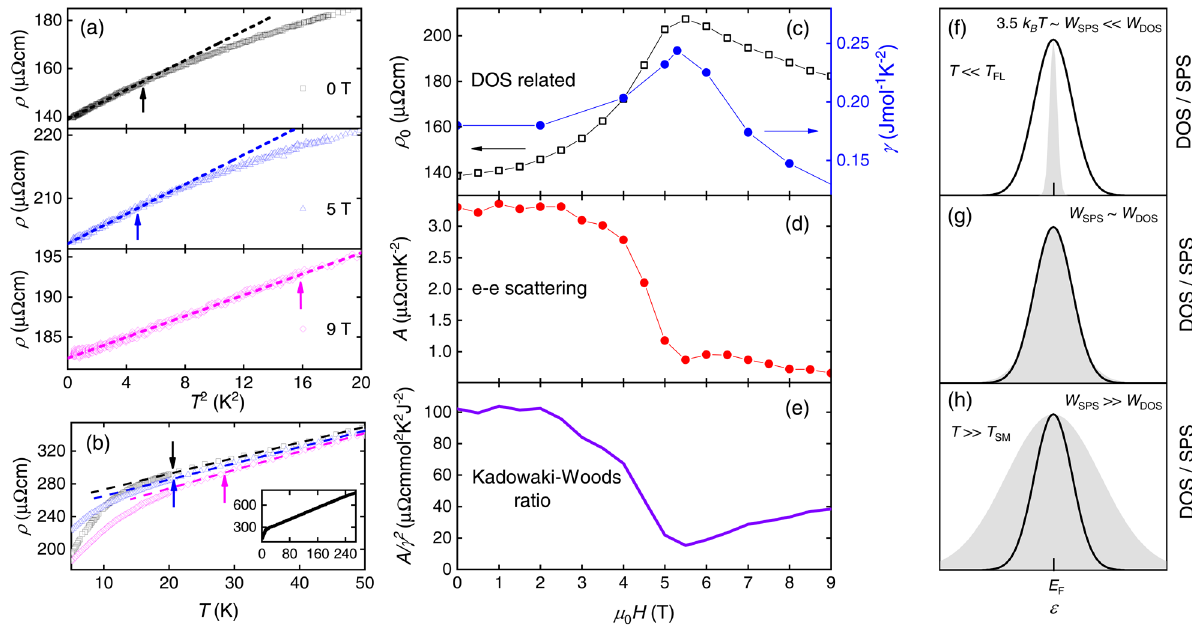
Fig. 2 Kadowaki – Woods ratio across the metamagnetic transition in Ca 1.8 Sr 0.2 RuO 4 . a Resistivity ρ plotted versus T 2 for selected fi elds. Dashed lines are linear fi ts to the low-temperature limit. Arrows indicate the temperature scale T FL above which the resistivity deviates from T 2 behavior. The temperature- independent term ρ 0 and coef fi cient of the T 2 term A are obtained from the intercept and the slope of the linear fi ts, respectively. b Resistivity ρ at higher temperatures plotted as a function of T for selected fi elds. The dashed lines are linear fi ts to the high-temperature end. Arrows mark the T SM scale below which resistivity deviates from a T -linear dependence. The inset shows the zero- fi eld curve up to high temperature, where the ordinate is ρ in the unit of μ Ω cm and the abscissa is T in K. c , d , e Magnetic fi eld dependence of ρ A , γ , and the Kadowaki – Woods ratio A / γ 2 . The Sommerfeld coef fi cient γ is 0 , extracted from ref. 60 . The error bars are smaller than the symbols. f , g , h Schematics comparing a density-of-states (DOS) peak pro fi le (black line) with the scattering phase space (SPS, represented by the gray shaded area) for increasing temperatures. The scattering phase space is de fi ned by f T ( ϵ )[1 − f ϵ )], where f ϵ ) is the Fermi-Dirac distribution for temperature T and energy ϵ measured from the Fermi level. Both pro fi les are centered around the T ( T ( Fermi level E F , although the DOS peak position in a real material is tunable by e.g., magnetic fi eld or pressure. As discussed in the text, the DOS peak width depends on dimensionality and disorder. Table 1 Fermi liquid behaviors as the density-of-states peak and the Fermi level are tuned to match. Compound